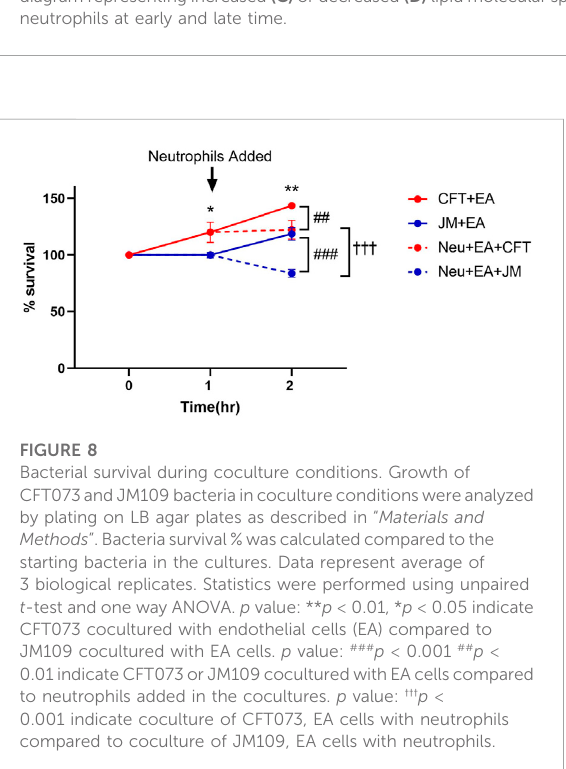
Differences in bacterial strain response with and without neutrophils at early and late time. Venn diagram representing increased (A) or decreased (B) lipidmolecularspeciesforcomparisonsbetweenCFT073culturedwithEAcellswithorwithoutneutrophilsatearlyandlatetime.Venn diagram representing increased (C) or decreased (D) lipid molecular species for comparisons between JM109 cultured with EA cells with or without neutrophils at early and late time.